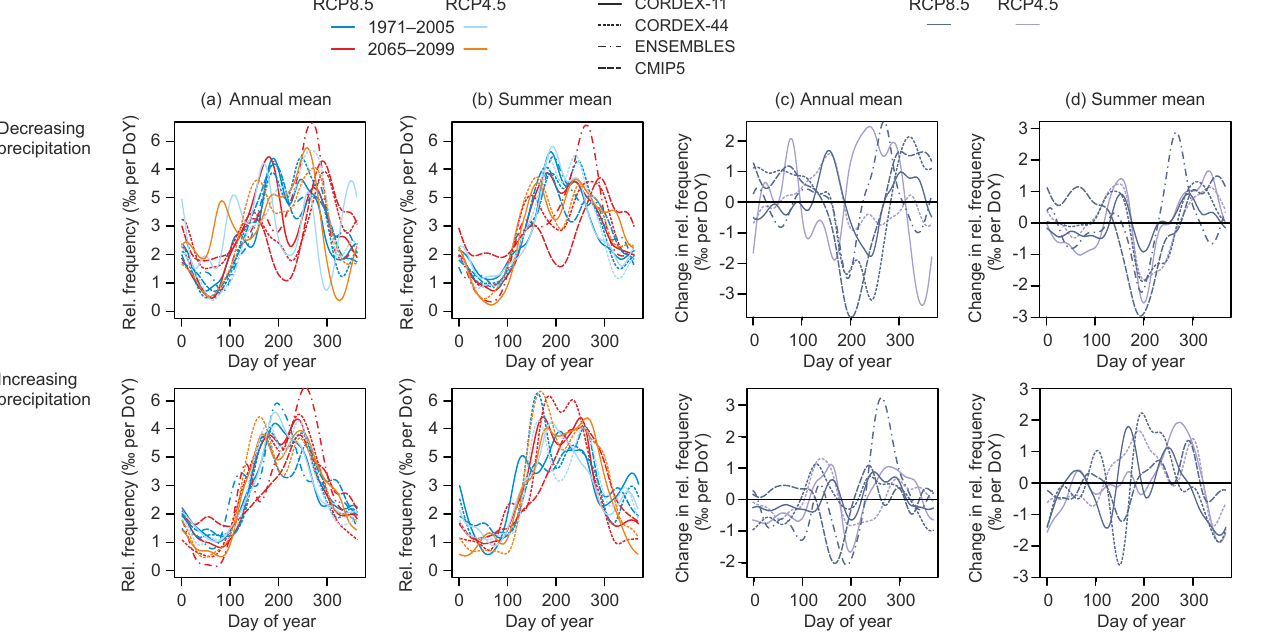
Figure 4. Density plot of the day of occurrence of Rx1day for the present (1971–2005) and future (2065–2099) in the different multi-model ensembles (a, b) . Panels (c, d) show the difference between future and present climate. Ensemble members are separated into those that show a positive or negative trend in annual mean (a, c) or summer mean (b, d) precipitation over the 1971–2099 period (see Fig. S4 for additional plots from other scenarios and different time